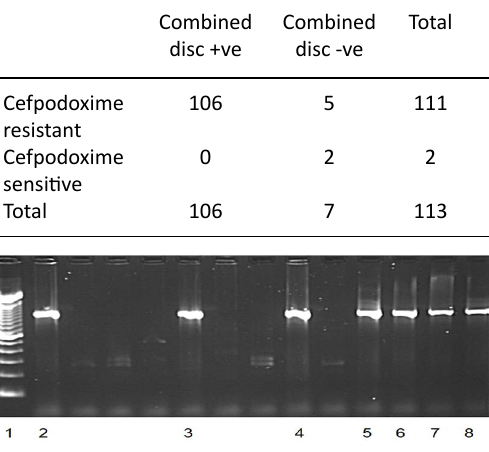
Fig. 2. PCR results of bla SHV positive isolates. Lane 1: Lambda DNA of a multiple 100bp size marker. Lanes 2, 3, 4, 5, 6 and 7: bla SHV positive isolates. Lane 8: positive